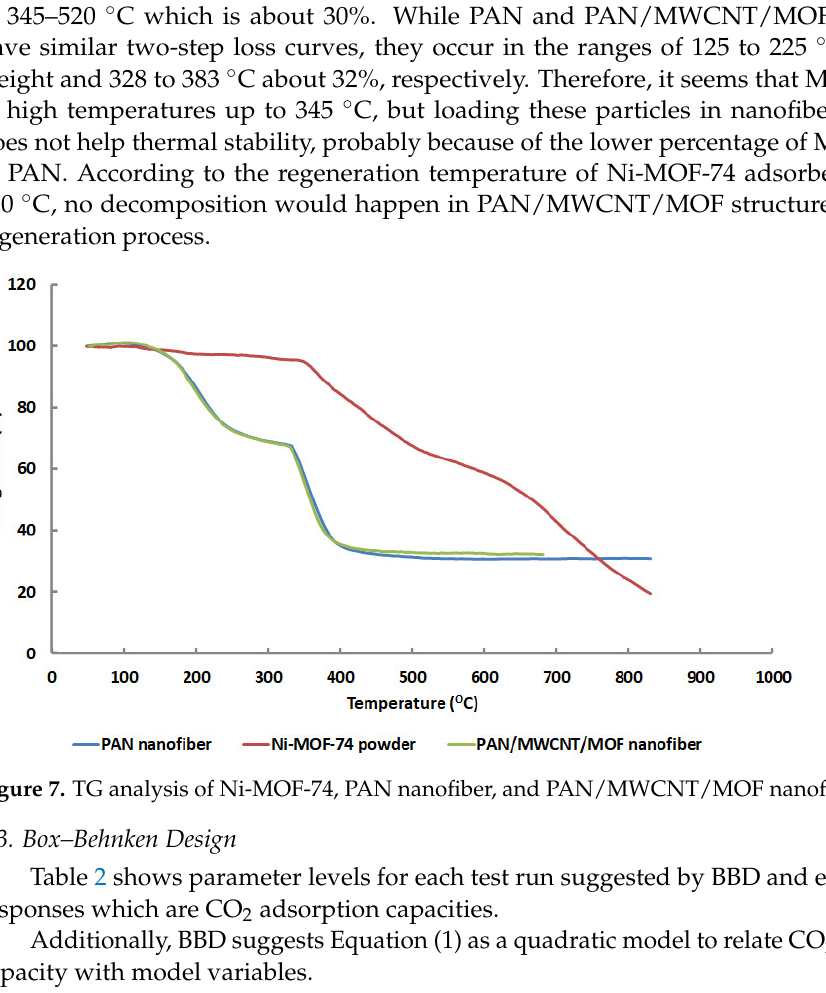
Figure 7. TG analysis of Ni-MOF-74, PAN nanofiber, and PAN/MWCNT/MOF nanofiber.